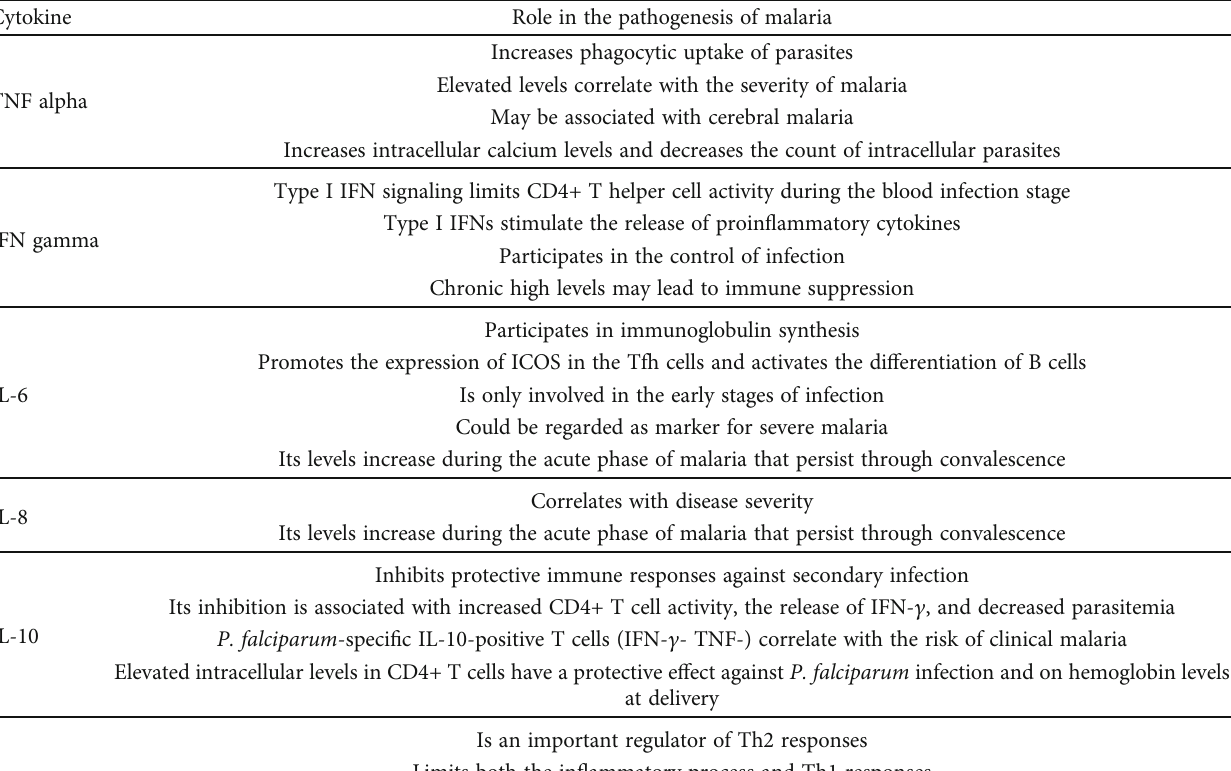
Table 1: The role of cytokines in the disease